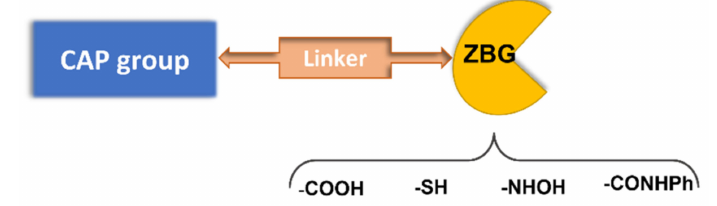
Figure 2. Pharmacophoric model for HDAC